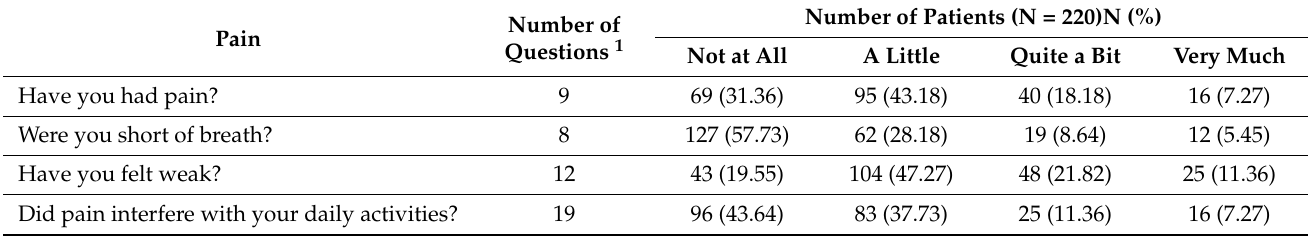
Table 4. Assessment of pain made by the patients.